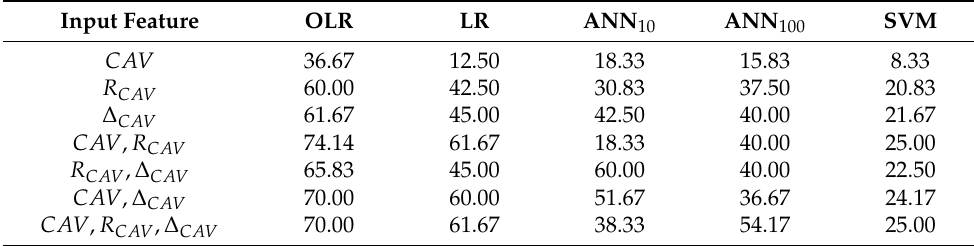
Table 2. Accuracy (%) of ML models for different feature combinations (Set-1: training & Set-2: test). Input